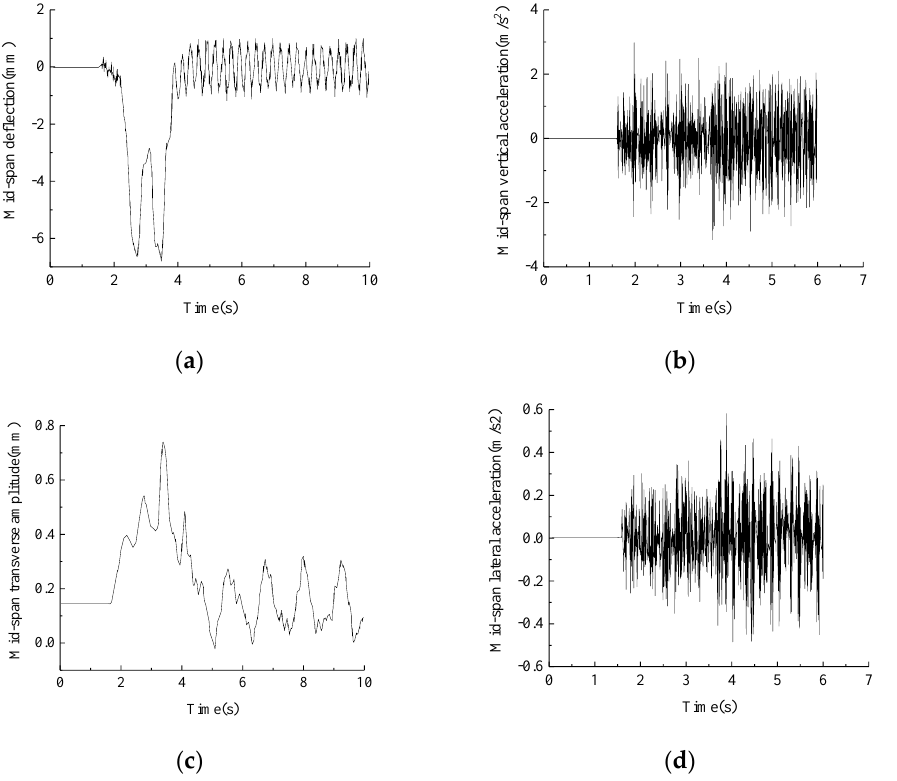
Figure 20. Mid−span vibration response of structure with damping ratio of 0: ( a ) Mid−span deflec- Figure 20. Mid − span vibration response of structure with damping ratio of 0: ( a ) Mid − span tion (mm). ( b ) Mid−span vertical acceleration (m/s 2 ). ( c ) Mid−span transverse amplitude (mm). (d) deflection (mm). ( b ) Mid − span vertical acceleration (m/s 2 ). ( c ) Mid − span transverse amplitude Mid−span lateral acceleration (m/s 2 ). (mm). (d) Mid − span lateral acceleration (m/s 2 ).